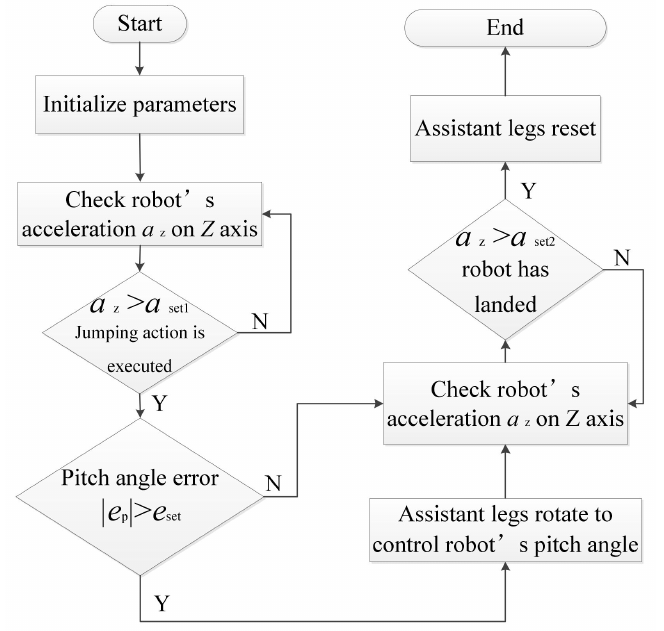
Figure 2. The working process of jumping robot’s control system. a set1 and a set2 are two set values of acceleration. e p and e set are the measured value and set value of pitch angle error, respectively, and 0 ◦ is the expected value of pitch